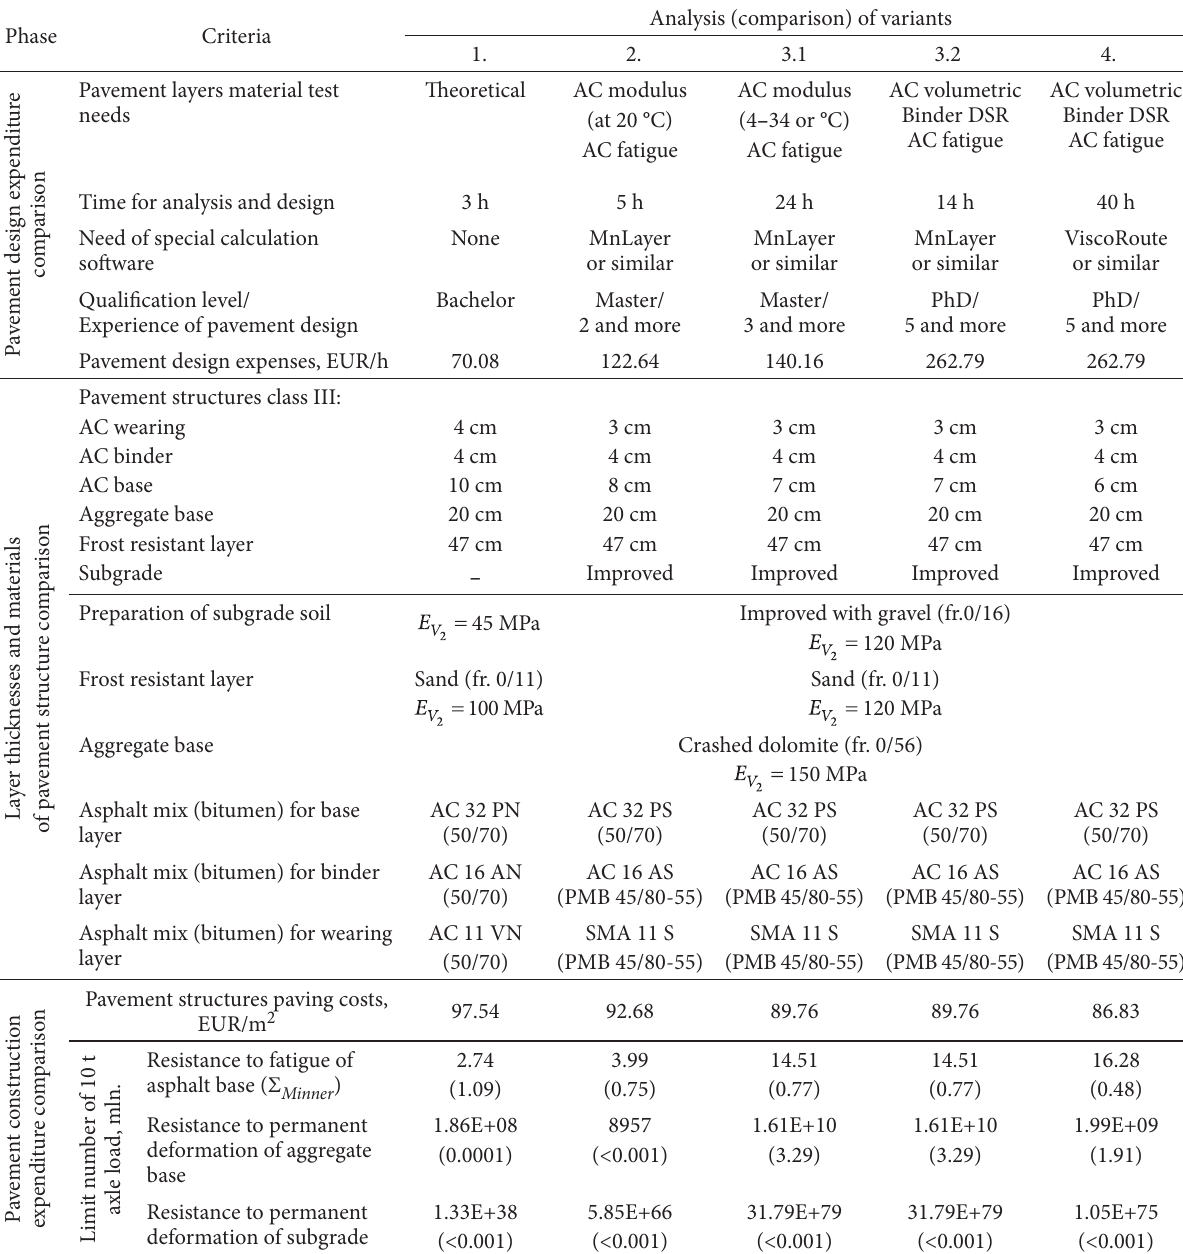
Table 4. The comparison criteria of pavement structures and design for economical evaluation Phase